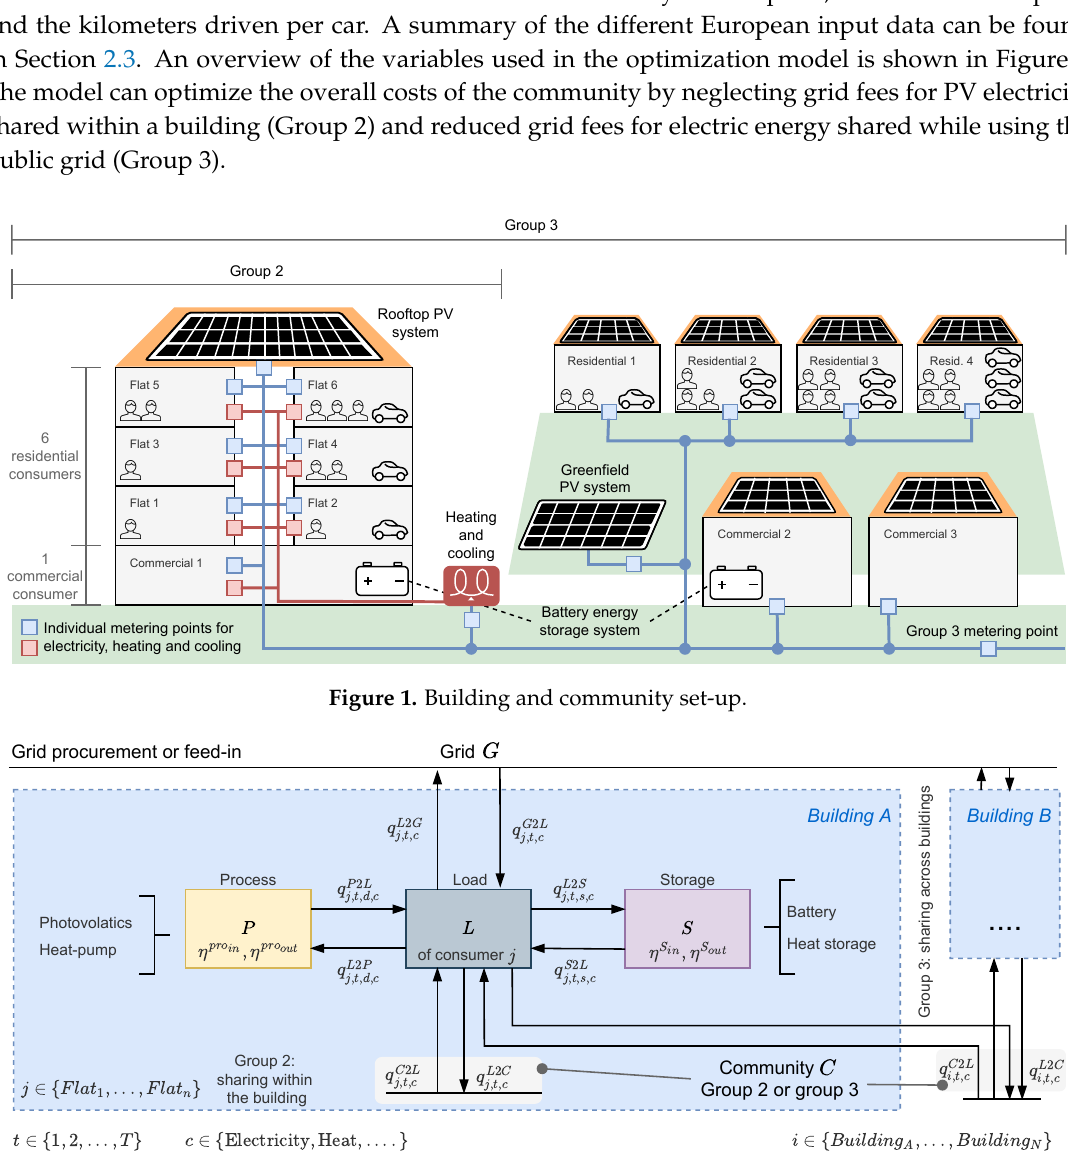
Figure 2. Overview of the energy flows within the optimization